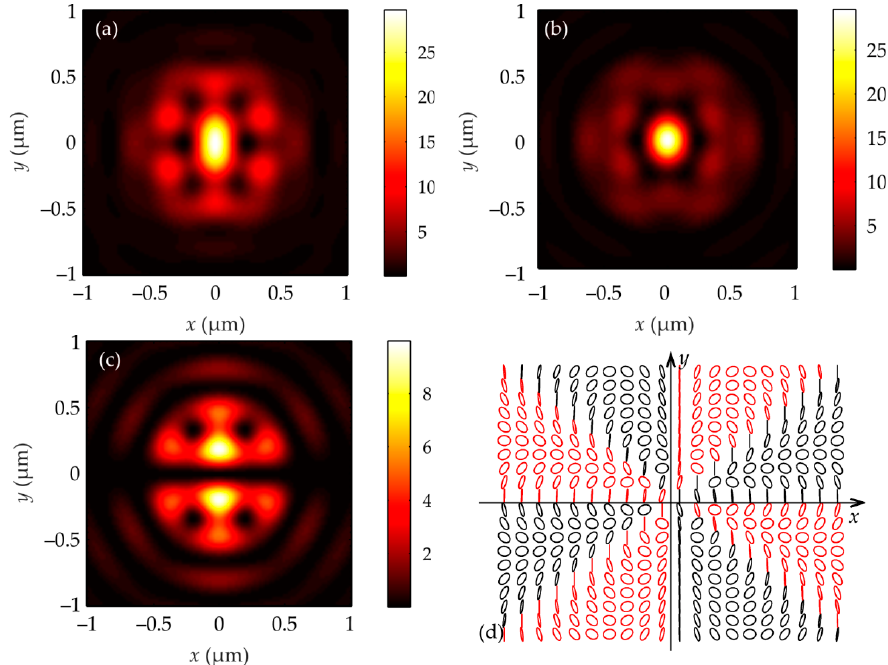
Figure 2. Distributions of the ( a ) total intensity for the initial field (11) I =| E x | 2 +| E y | 2 +| E z | 2 and components thereof: ( b ) transverse | E x | 2 +| E y | 2 and ( c ) longitudinal | E z | 2 in the focal plane ( m = 4, a = 1). ( d ) Schematic arrangement of the polarization vectors of the source field, with the opposite-handed vectors depicted by different colors.